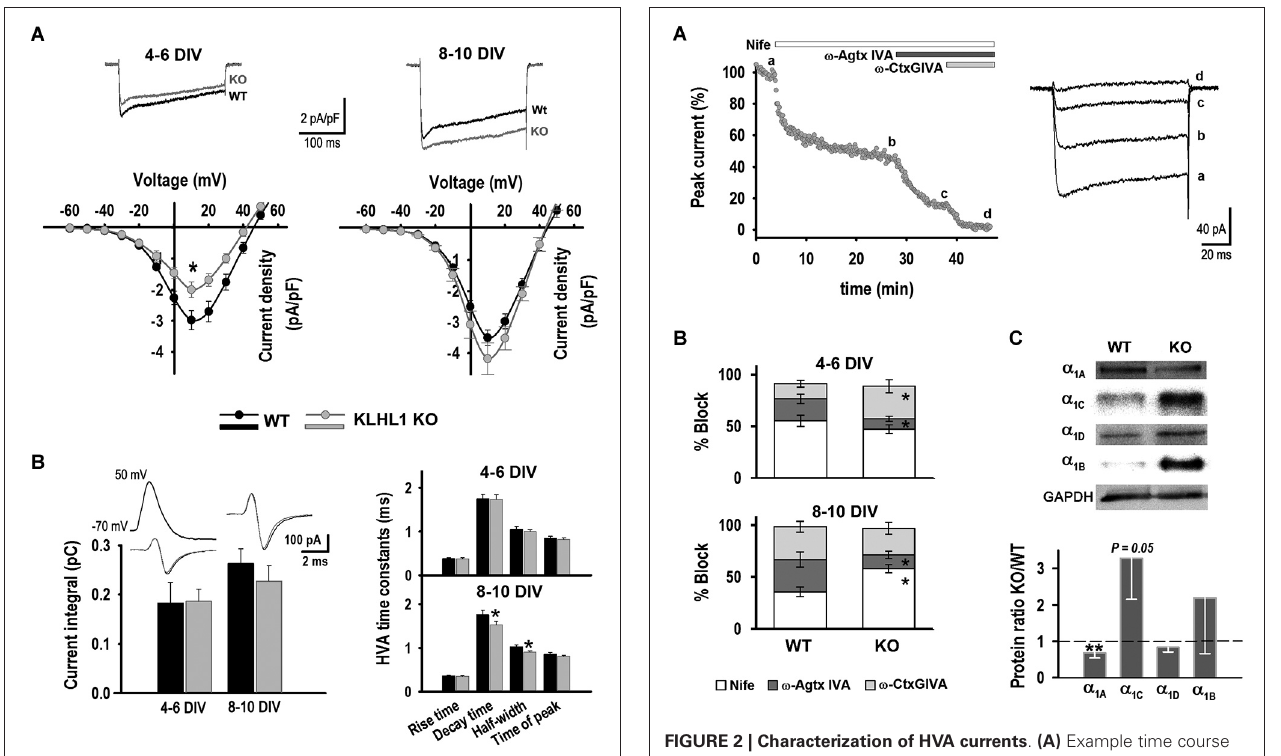
FIGURE 1 | HVA calcium currents . (A) Current density I-V curves of HVA currents at 4–6 DIV and 8–10 DIV, V H = − 50 mV. Average traces from V T = − 60 to +10 mV are shown (4–6 DIV: n = 22, 18; 8–10 DIV: n = 15, 13). (B) Calcium current elicited by APW ( n = 22, 34 and 21, 23); time constant values are shown to the right. * p < 0.05, Student’s t -test.